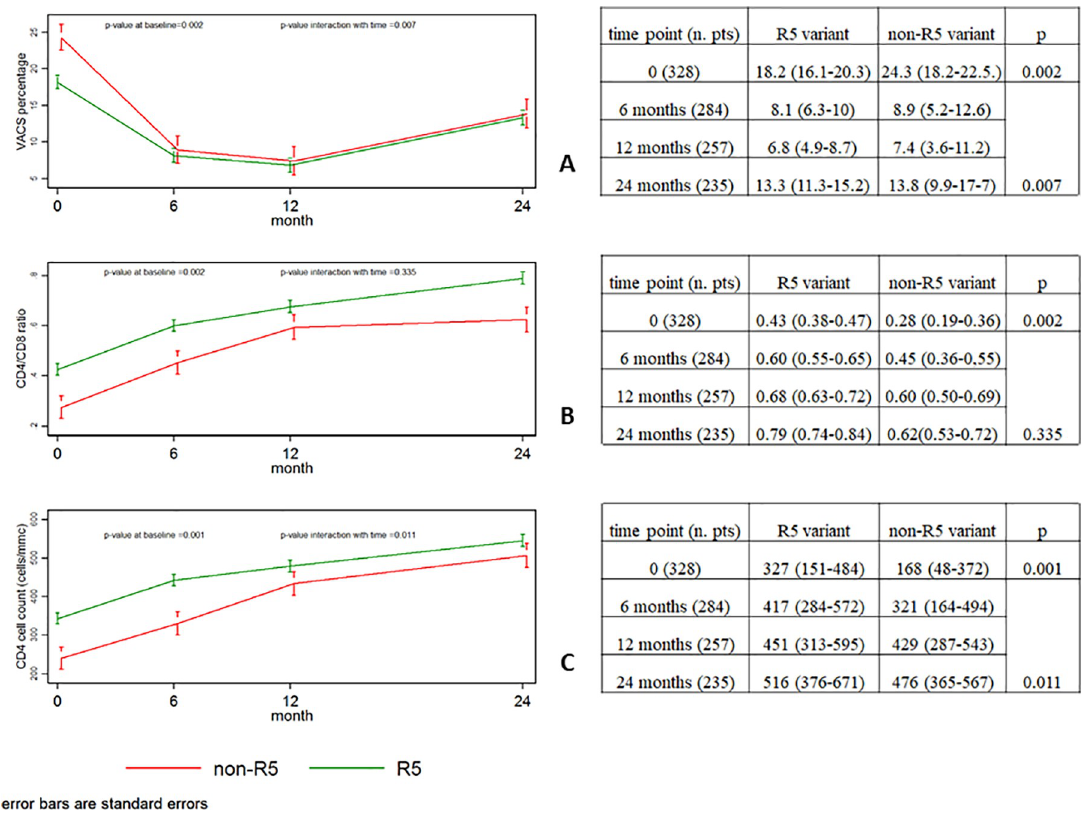
Fig 1. Coreceptor tropism and VACS percentage risk (A), CD4/CD8 ratio (B) and CD4 cell count (C): association at diagnosis and changes over time. https://doi.org/10.1371/journal.pone.0212882.g001 At multivariable analysis, non-R5 patients had a higher VACS percentage risk than R5 patients, after adjusting for sex, HIV risk factor and subtype (Table 3).